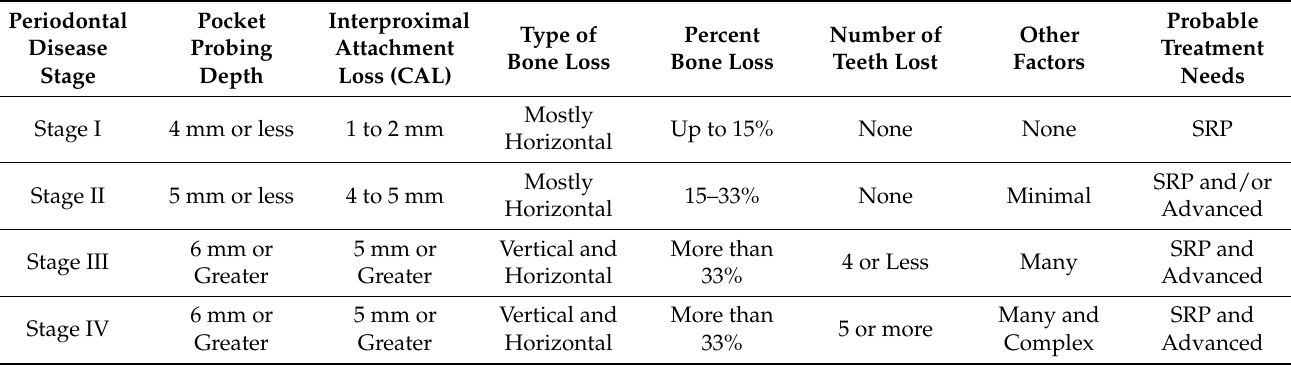
Table 1. A simplified diagnostic and treatment summary drawn from the staging criteria from the 2018 Classification of Periodontal and Peri-implant Diseases and Conditions. The original classification papers should be consulted for